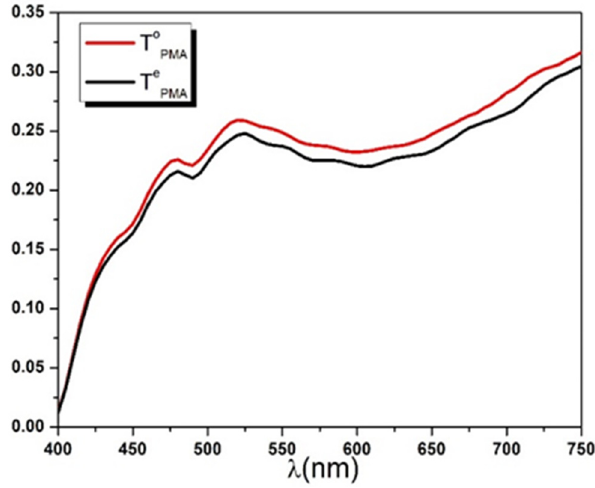
Figure 7. Ordinary and extraordinary intensity transmittances of the Polarizer-Mylar-Analyzer sys- tem.